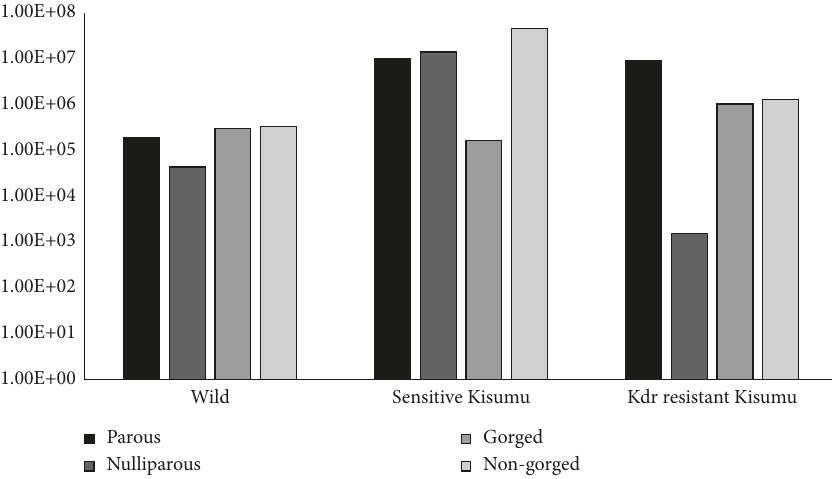
Figure 1: Different pool of Anopheles gambiae according to their bacterial loads. Table 1: Results of the analysis of the variance test of the different batches of Anopheles gambiae mosquito in the parous category. Source of variations Sum of squares Degree of freedom Average of squares F Probability (%) Critical value for F Between pools